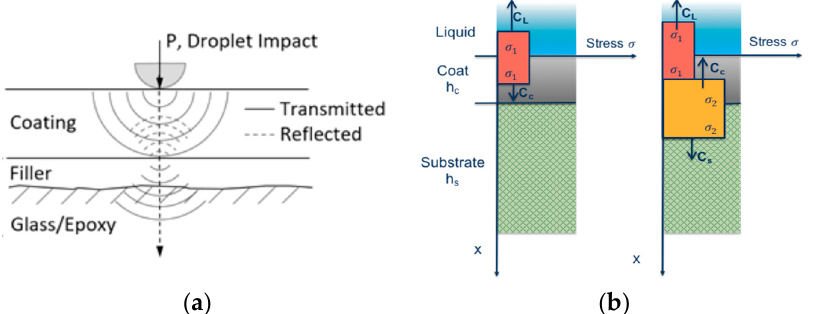
Figure 9. ( a ) Standard blade structure with a filler intermediate layer; ( b ) normal shockwave propagation depending on acoustic impedances in two consecutive time instants.